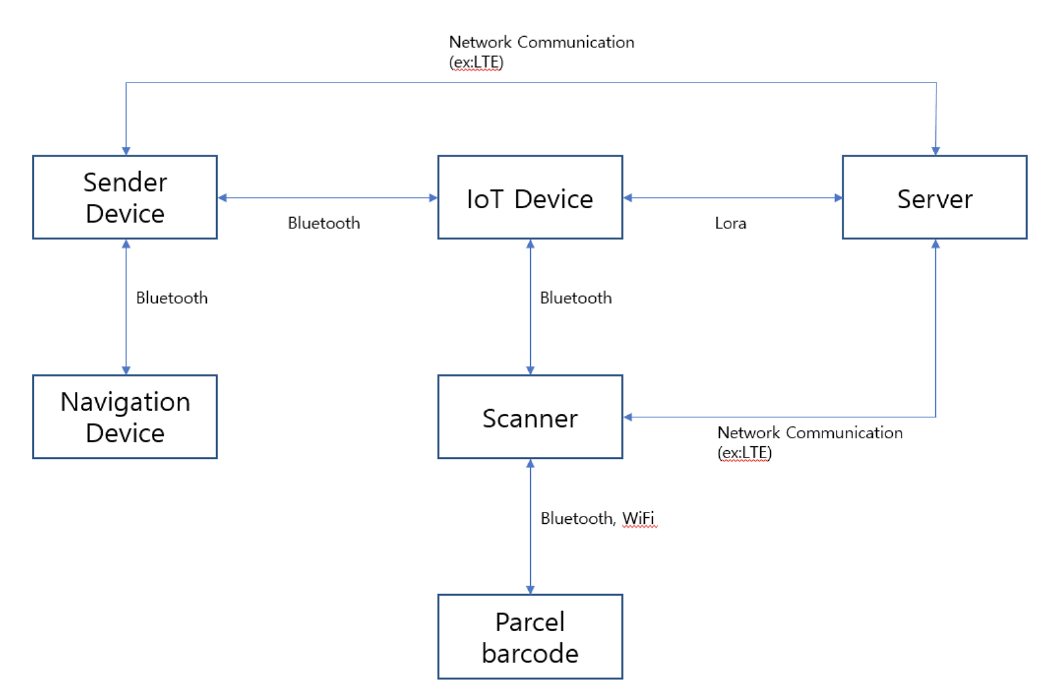
Figure 2. Wireless connection of Improved Parcel Delivery System